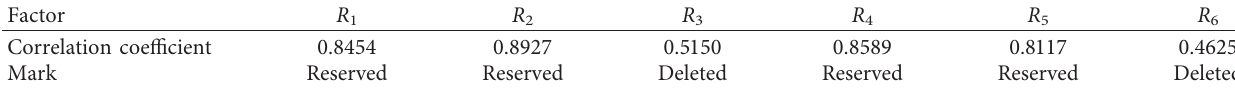
Table 2: Correlation coefficients of influencing factors.